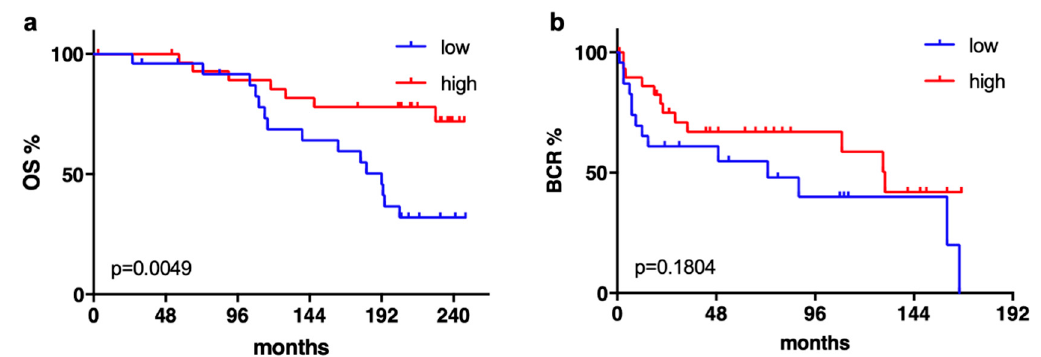
Figure 2. ( a ) In the Mannheim cohort, a low expression of SMPDL3B correlated with a significantly shorter overall survival (OS) but ( b ) not with a shorter biochemical recurrence (BCR)-free survival of patients with localized prostate cancer (PCa) who underwent RP.